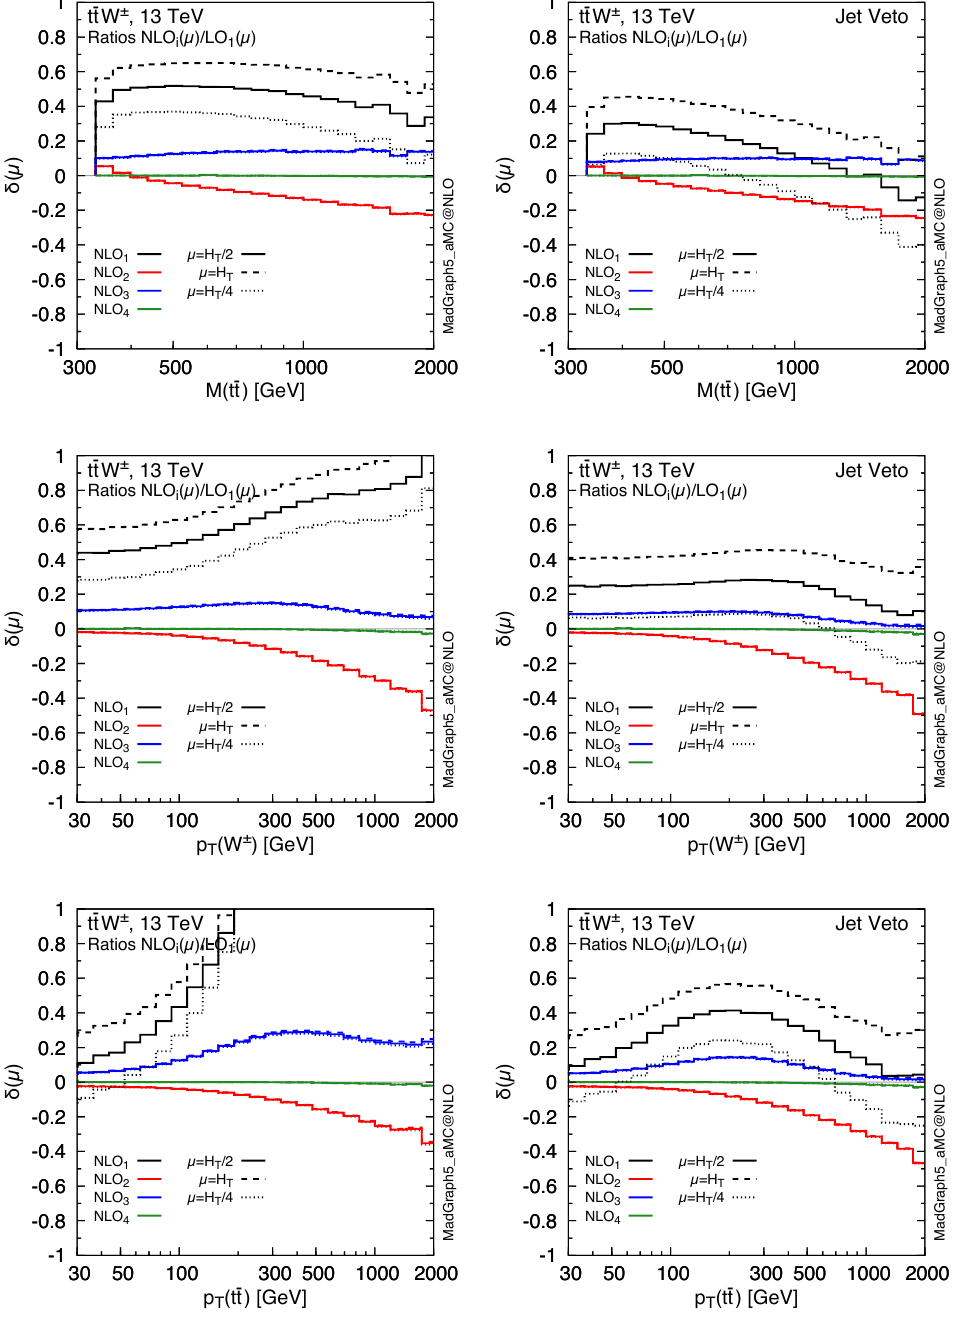
Figure 7 . Individual NLO i contributions to t (cid:22) tW (cid:6) production at 13 TeV normalised to LO 1 (cid:17) LO QCD , for di(cid:11)erent values of the scale (cid:22) for the same distributions as considered in (cid:12)gure 5.